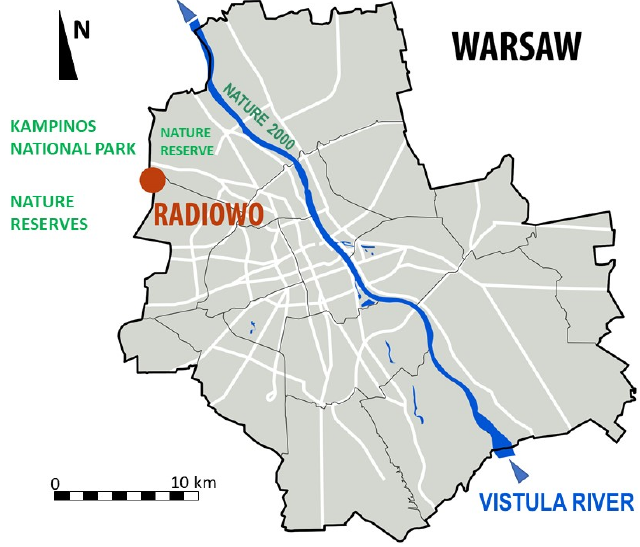
Figure 1. Location of the study site.